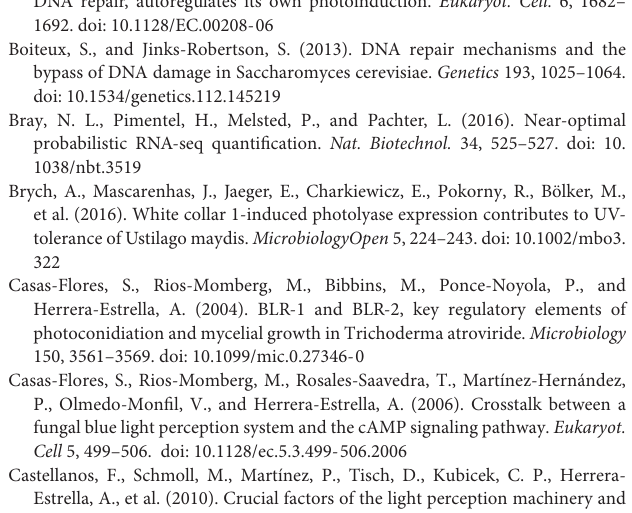
fungal name, respectively. Bootstrap values of 1000 are given at the nodes. Scale: length of the branch proportional to the genetic distance evaluated with the neighbor-joining method in MEGA X. Supplementary Figure 2 | General characterization of env1 gene replacement mutants. Confirmation of gene replacement event. A PCR was carried out using a primer within the coding sequence of the hph gene (hygromycin resistance cassette) as forward and a primer derived from the UTR region of the env -1 gene as reverse. In this experiment the amplifying strains had integration of the construct in the correct region of the genome (A). PCR to amplify the env -1 gene. In this experiment the strains that do not show amplification are pure mutants (B) . Light induced conidiation of four env- 1 independent mutants (C) . Supplementary Figure 3 | Total growth of colonies under constant darkness. Growth was measured every 12 h for 72 h under darkness on potato dextrose agar (PDA) ( n = 8). Supplementary Figure 4 | Effects of constant blue light on the growth and conidiation at 2.9 µ mol.m − 2 s − 1 . The strains were exposed to a 2.9 µ mol · m − 2 · s − 1 dose of blue light for 72 h. (A) Phenotype of the WT strain and the (cid:49) env- 1 mutant under constant lighting and darkness. (B) Conidia per plate of strain WT and mutant (cid:49) env- 1 under constant illumination. Supplementary Figure 5 | Effects of constant blue light on the growth and conidiation at 11.6 µ mol.m − 2 s − 1 . The strains were exposed to a dose of 2.9 µ mol · m − 2 · s − 1 blue light for 72 h. (A) Phenotype of the WT strain and the (cid:49) env- 1 mutant under constant lighting and darkness. (B) Conidia per plate of strain WT and mutant (cid:49) env- 1 under constant illumination. Supplementary Figure 6 | Distribution of reads mapping to the env -1 gene. The figure shows a 3249 nucleotides genomic region containing the env -1 gene. The diagram shows the RNA seq reads mapping to this region when the WT strain (red) or the (cid:49) env -1 (blue) were exposed to a pulse of blue light. At the bottom of the figure, we show a diagram of the structure of the env -1 gene indicating in light green rectangles exons, black lines introns and in dark green rectangles the 5 (cid:48) and 3 (cid:48) untranslated regions. Arrow heads indicate the direction of transcription. Supplementary Figure 7 | Genes regulated by Cry-1 y Cry-DASH. (A) Venn diagram showing the number of up-regulated genes shared by the WT strain and the (cid:49) cry -1 and (cid:49) cry-DASH mutants or that are unique for each strain. (B) Venn diagram showing the number of down-regulated genes shared by the WT strain and the (cid:49) cry -1 and (cid:49) cry-DASH mutants or that are unique for each strain. Supplementary Figure 8 | Trichoderma atroviride tolerance to UV light. Colonies of the WT strain and the (cid:49) cry -1 and (cid:49) env -1 mutants were incubated for 48 h in the dark after irradiation with 350 J. m − 2 UV-C